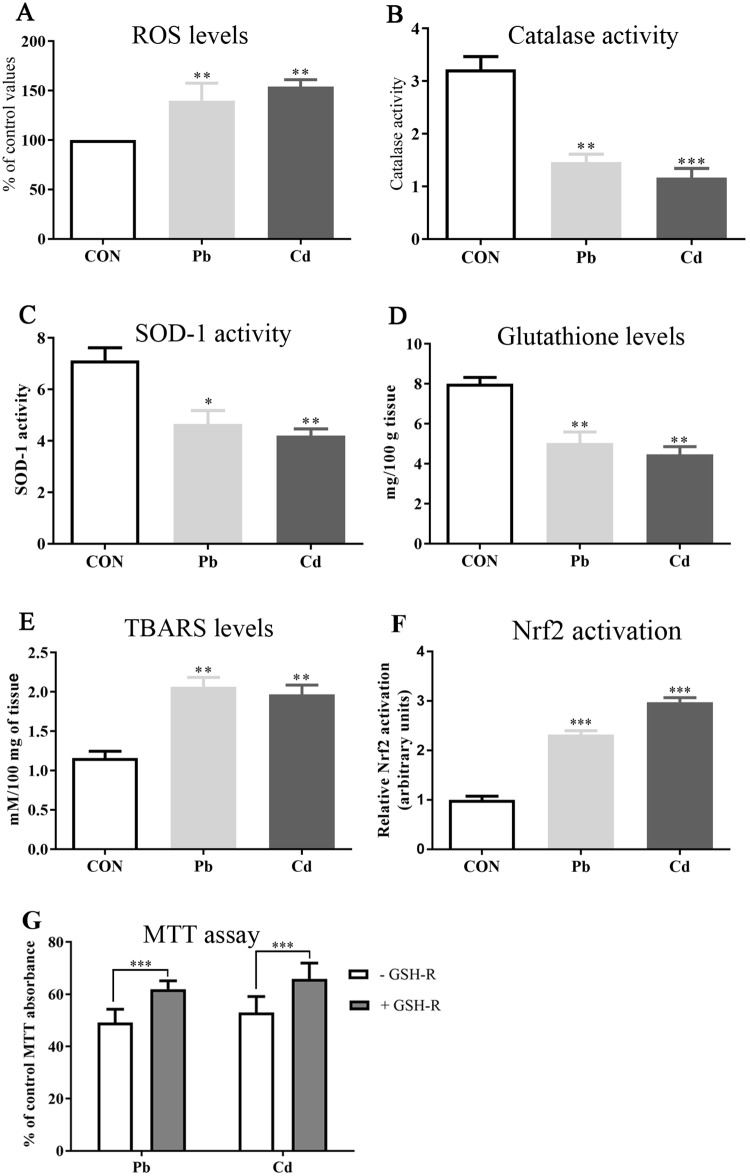
The effect of lead or cadmium on redox status of human osteoblasts.Human osteoblasts were treated with lead (Pb) (55 μM) or cadmium (Cd) (30 μM) for 24 hours, and the production of ROS (A), catalase activity (B), superoxide dismutase-1 (SOD-1) activity (C), intracellular reduced glutathione levels (D), production of thiobarbituric acid reactive substances (TBARS) (E), and activation of Nrf2 (F) quantified. Human osteoblasts were treated with reduced glutathione prior to treatment with lead or cadmium, and the level of cytotoxicity determined using an MTT assay (G). Significant differences from controls are marked with asterisks. Data are representative of 5–9 independent experiments. For * = p-value < 0.05, ** = p-value < 0.01, *** = p-value < 0.0001.